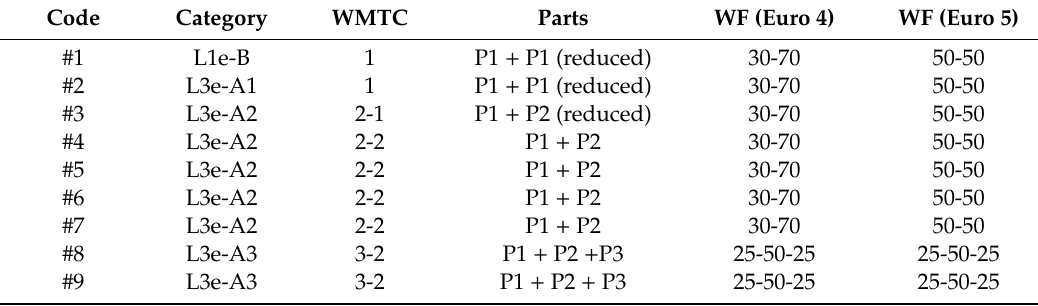
Figure 2. Test cycle (WMTC) and parts. Dashed lines show the reduced speed version. Test cycles for each PTW. P1-P3 refer to parts 1–3 of the driving cycle (Figure 2). Reduced = reduced speed profiles as in Regulation 2014 /